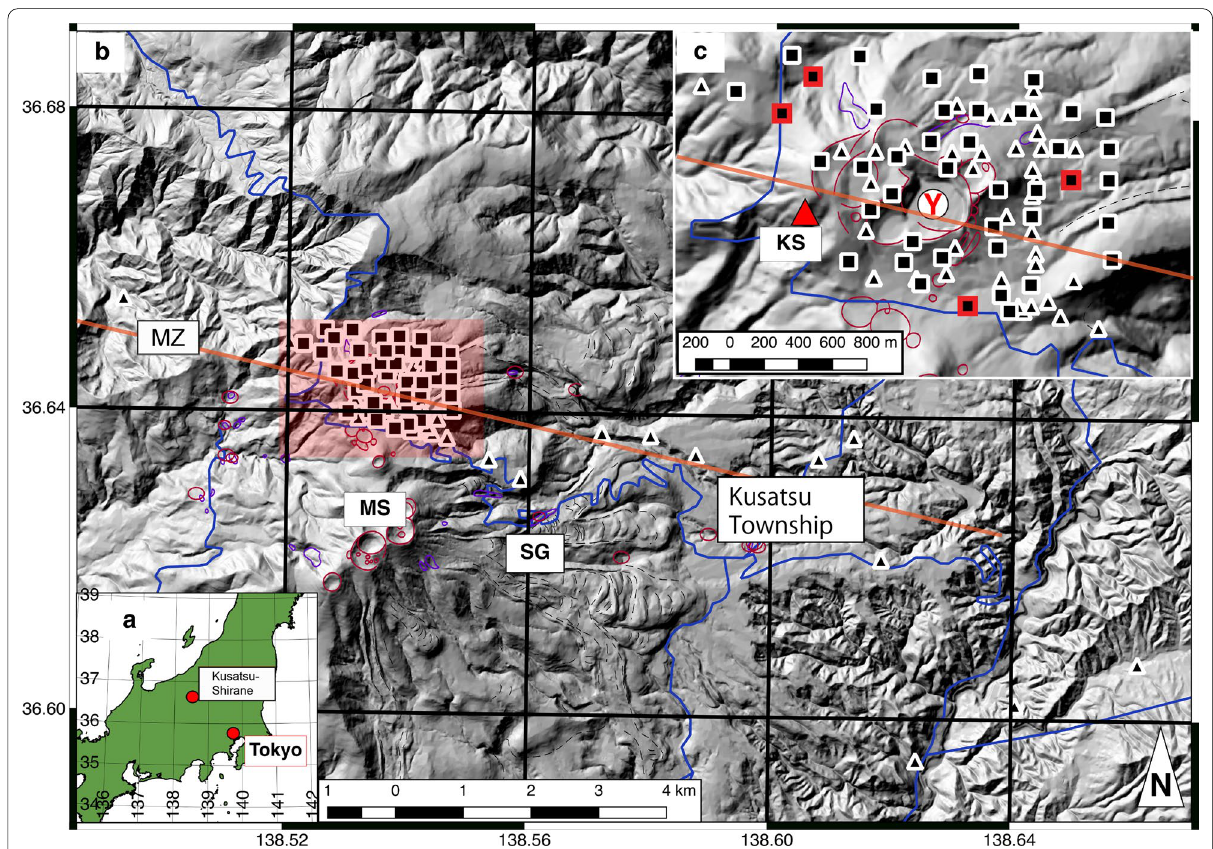
Fig. 1 a Location of Kusatsu–Shirane Volcano, Japan. b Topography map of Kusatsu–Shirane Volcano with MT/AMT stations. The squares and triangles denote the MT and AMT stations, respectively. The red circles and open curves show the crater rims of past eruptions. The purple closed curves show the fumarole zones. The blue curves show the national road 292 as a location reference. SG, MS, and MZ denote the locations of Sesshougawara fumarolic area, Mt. Motoshirane, and Manza hot spring field, respectively. The long orange line denotes a section in Additional file 2: Figure S23. c A peak area [the red rectangle in ( b )] of Kusatsu–Shirane Volcano with MT/AMT stations. The symbols are the same as in ( b ). Moreover, the black squares with red and with white edges denote the MT station with and without magnetic field data, respectively. KS denotes Mt. Shirane, and the red triangle denotes its peak. Y denotes the Yugama crater